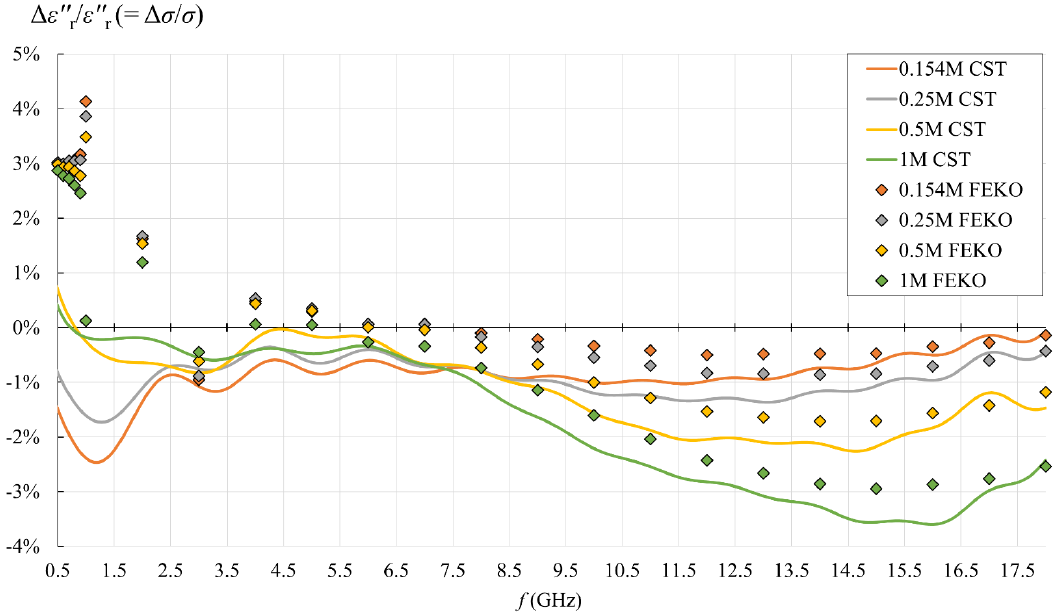
Figure 16. 𝜀 r″ relative error of the simple capacitive-load model (FEKO: discrete points; CST: solid lines) with respect to the set 𝜀 r″ value.